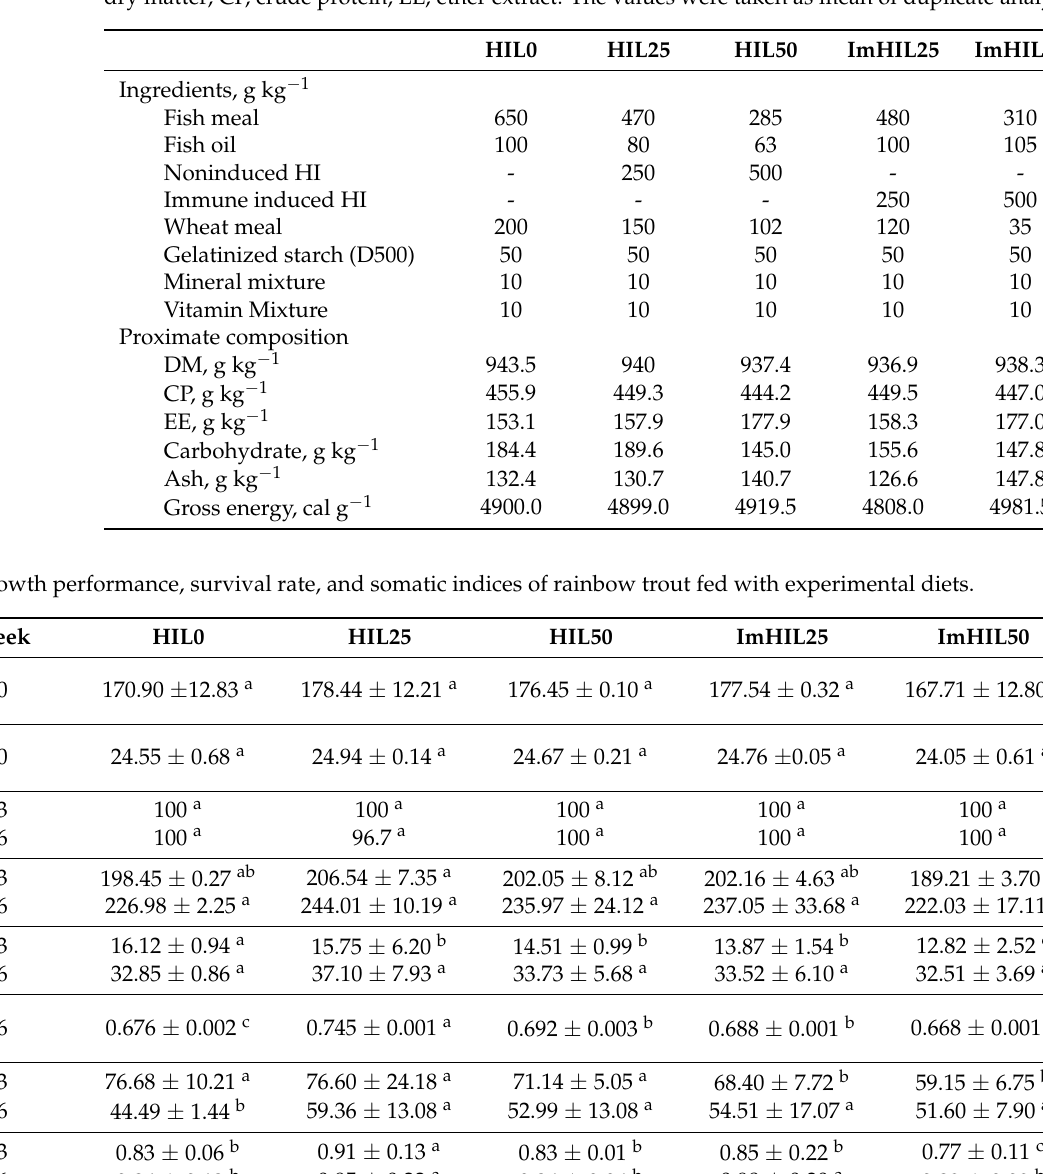
Table 2. Proximate composition of formulated rainbow trout feed. HIL0, 0% HIL; HIL25, 25% nonimmunized HIL replacement based on the weight of fishmeal; HIL50, 50% nonimmunized HIL replacement based on the weight of fishmeal; ImHIL25, 25% immunized HIL replacement based on the weight of fishmeal; ImHIL50, 50% immunized replacement based on the weight of fishmeal. DM, dry matter; CP, crude protein; EE, ether extract. The values were taken as mean of duplicate analysis.